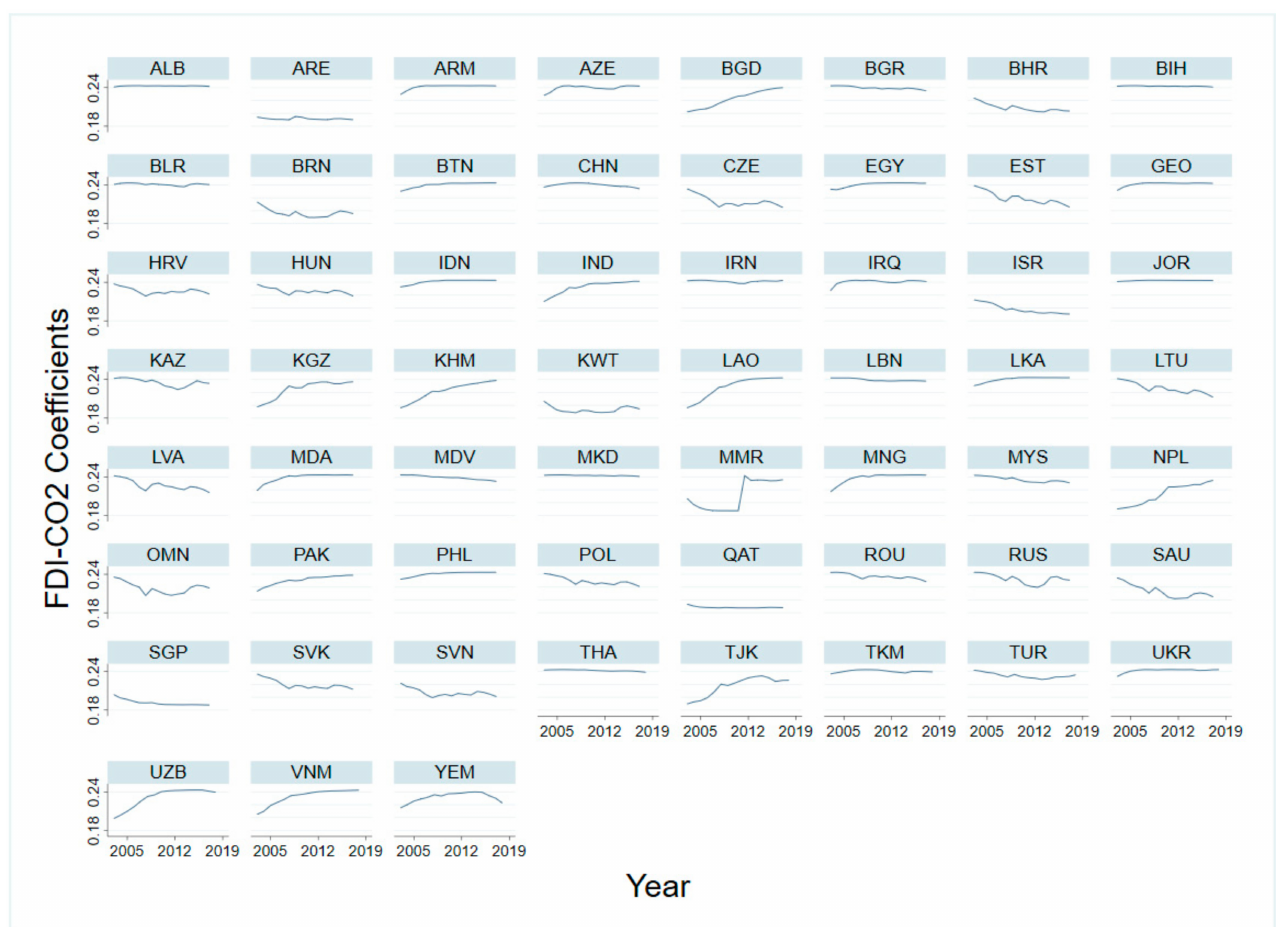
Figure 7. Estimated FDI-CO 2 individual coefficients: PSTR Model A. Notes: All estimates are based on model A of Table 4. Abbreviations (listed in the order of the countries): ALB (Albania),